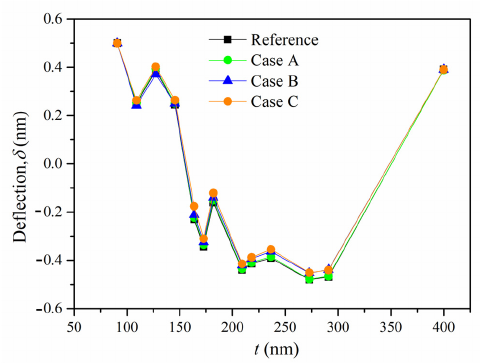
Figure 14. The deflection comparisons between the reference model and the three cases with a geometric error.